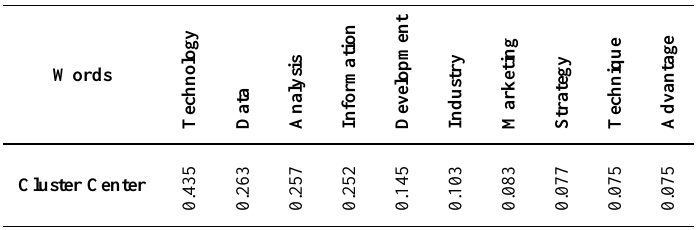
Table 5. Words and final centers of fourth cluster.